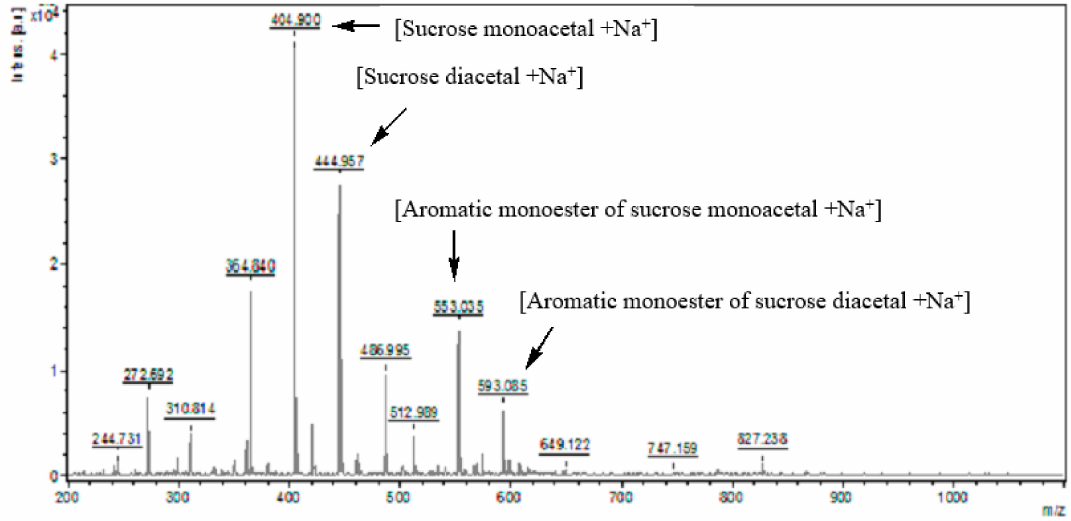
Figure 3. MALDI-TOF MS spectra of the reaction mixture from acylation of monoisopropylidensucrose and 2,1 (cid:48) ,4,6-di- O -izopropiliden sucrose with HPPA in the presence of Novozyme 435, after 72